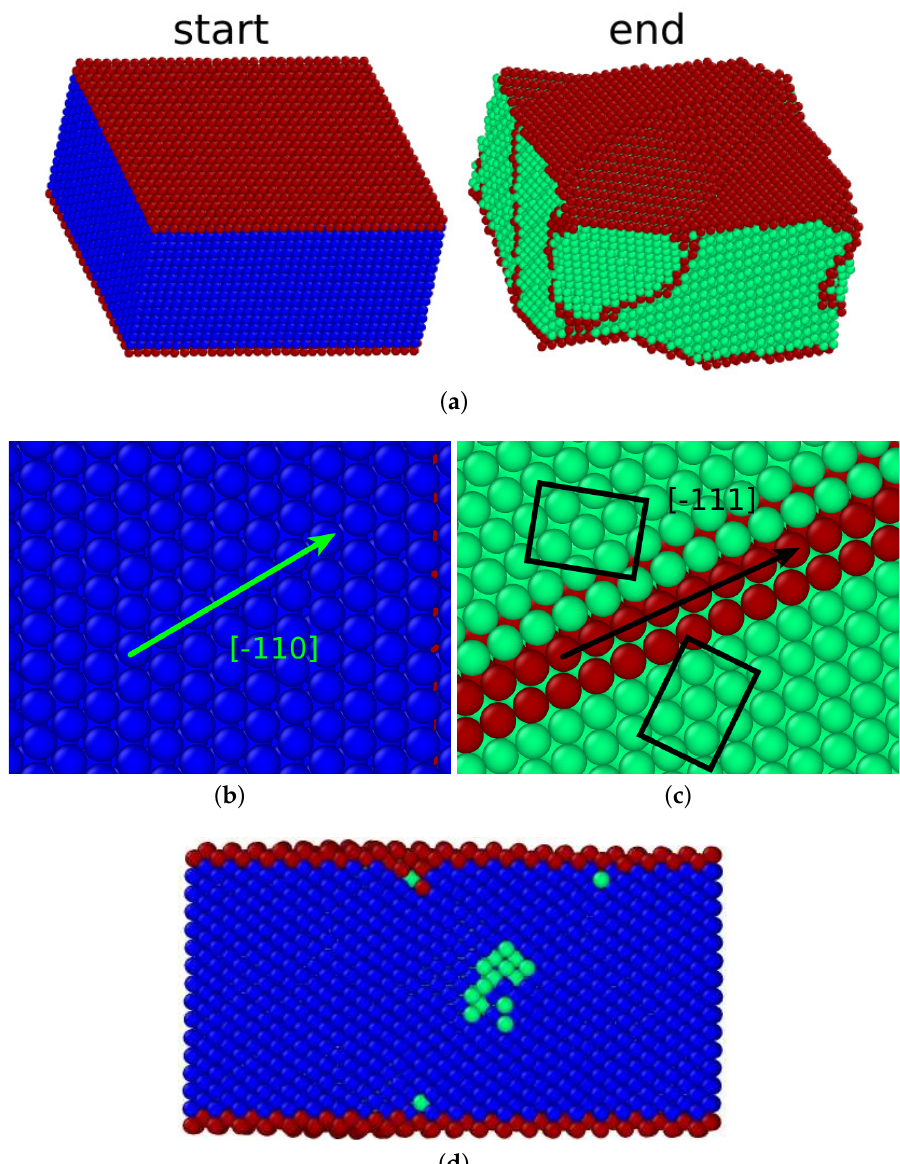
Figure 8. Martensitic transformation of a thin-film fcc Fe slab with a (110) surface: ( a ) perspective views of the film before and after the transformation; and ( b , c ) an oblique cut through the crystal where the close-packed ( 111 ) fcc plane ( c ) transforms into the ( 110 ) bcc plane ( d ). Here, the green (black) arrow highlights the conserved direction, while the black rectangles display the twin structure. ( d ) Side view of the film immediately after start of the transformation showing phase nucleation in the film interior. Colors denote the local lattice structure as in Figure